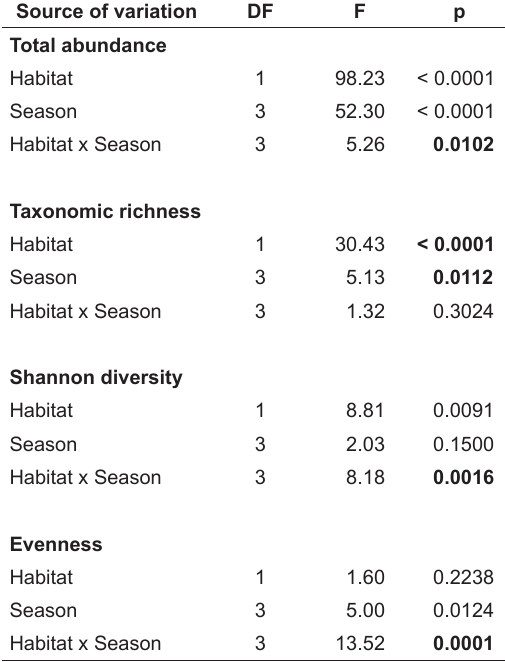
Table 4. Results of ANOVAs showing the effect of habitat type and seasons on macroinvertebrate benthic community attributes. Significant p values are in bold.